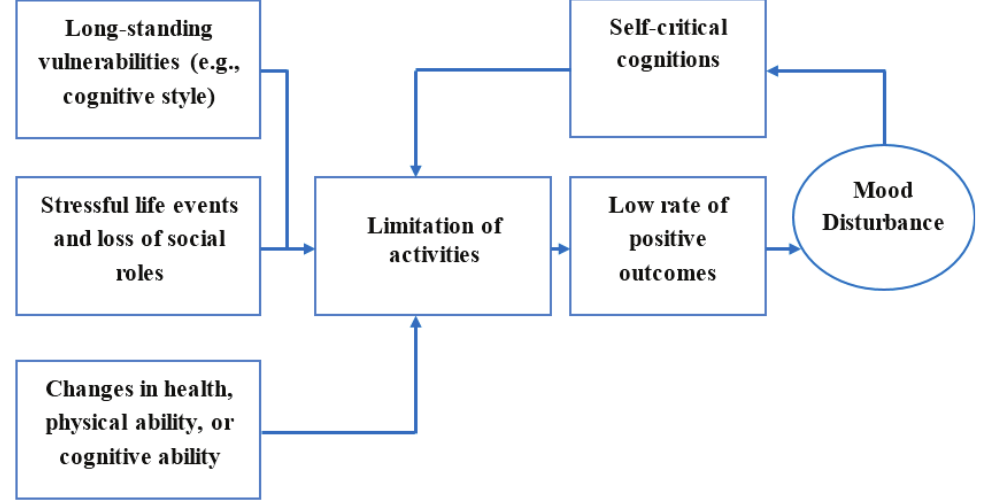
Figure 1. Behavioral model depicting onset and maintenance of depression in late life